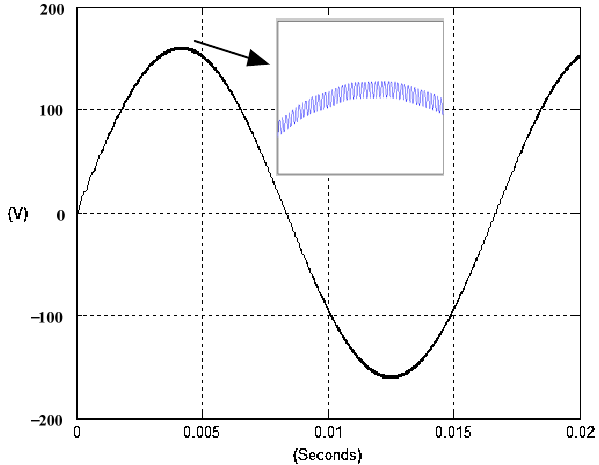
Figure 11. Simulated AC output voltage for the open loop at full load.